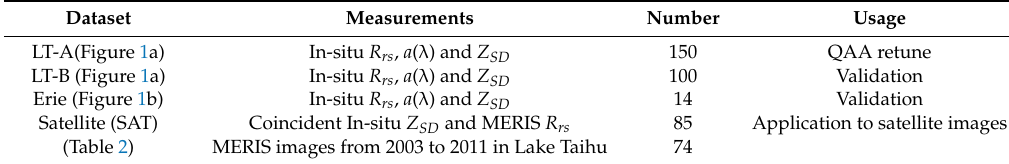
Table 1. List of datasets used in this study.